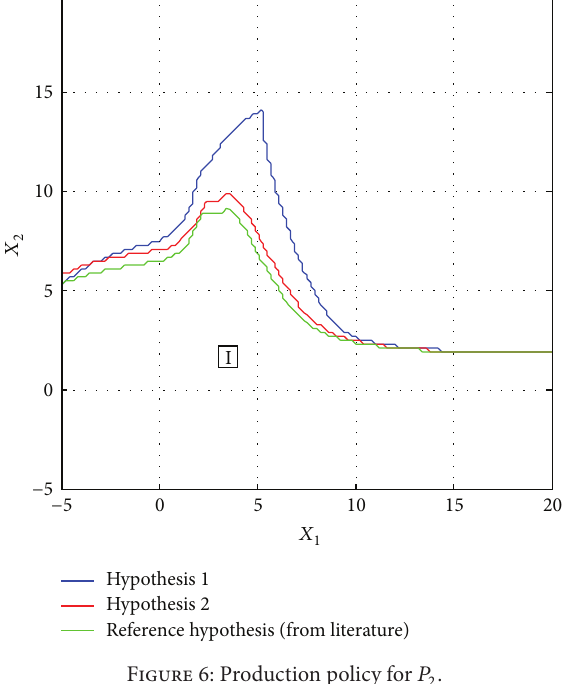
Figure 6: Production policy for 𝑃 2 .